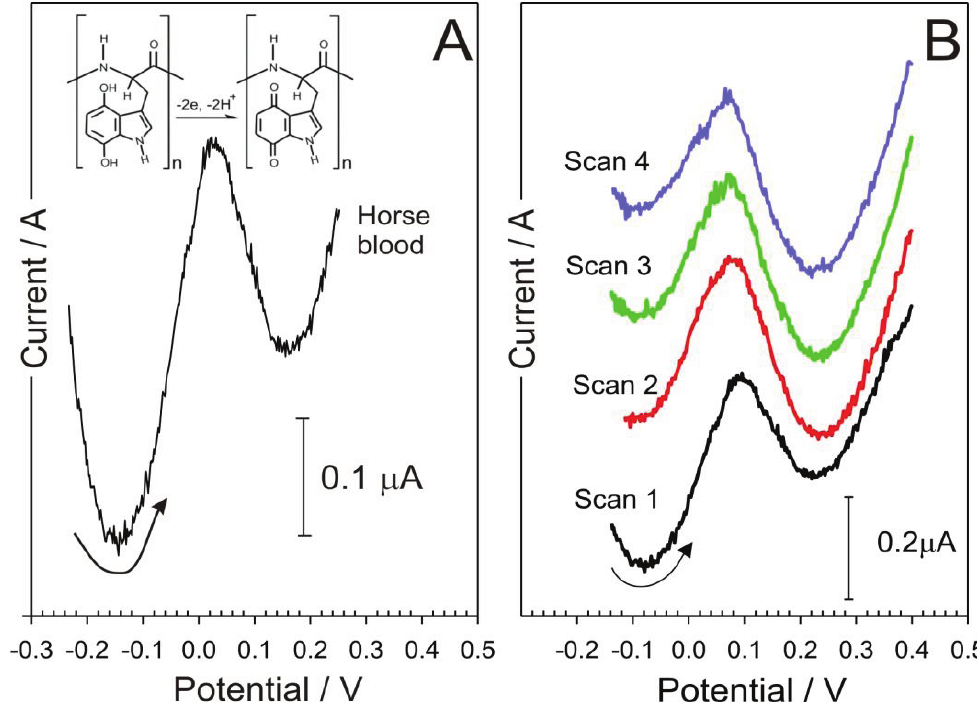
Figure 7 Square wave voltammograms detailing the electrode response to horse blood ( A ); and consecutive scans ( B